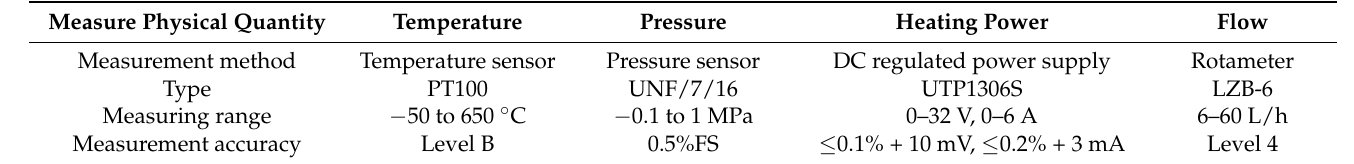
Figure 3. Angle adjustment diagram of non-uniform heat flux heating pulsating heat pipe experi- mental device. ( a ) Details of steering corner pieces. ( b ) Three-dimensional drawing of steering angle. ( c ) Installation position of multiple steering angle pieces. Table 1. Measuring physical quantity and precision of experimental